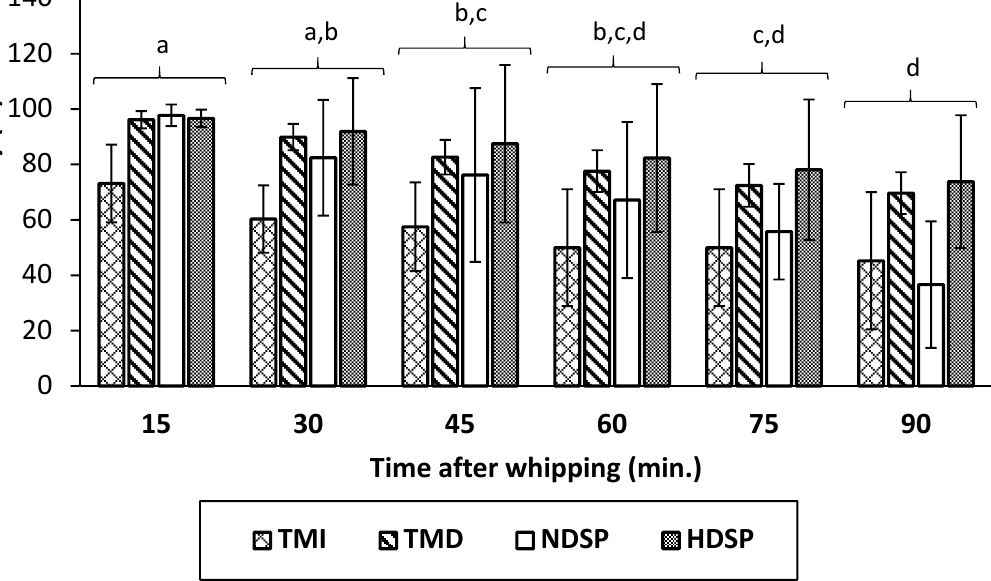
Figure 5. Foam stability values as a function of time after whipping of TMI, TMD, NDSP, and HDSP. Different letters indicate significant differences ( p < 0.05).